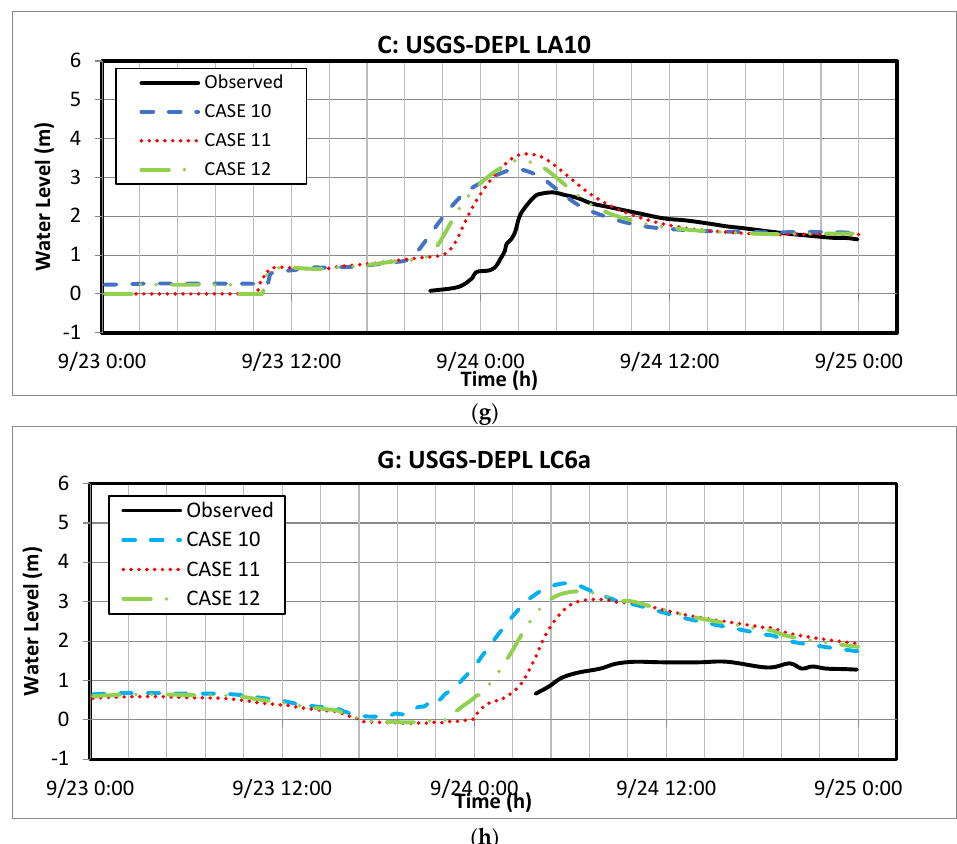
Figure 12. Effect of simultaneously decreasing and increasing manning’s n and wind drag: Observed and SWAN + ADCIRC modeled significant water level time series at different observation stations during the time of Hurricane Rita (9/23-25/05). ( a ) J—USGS-DEPL LF5; ( b ) H—USGS-DEPL LC8a; ( c )